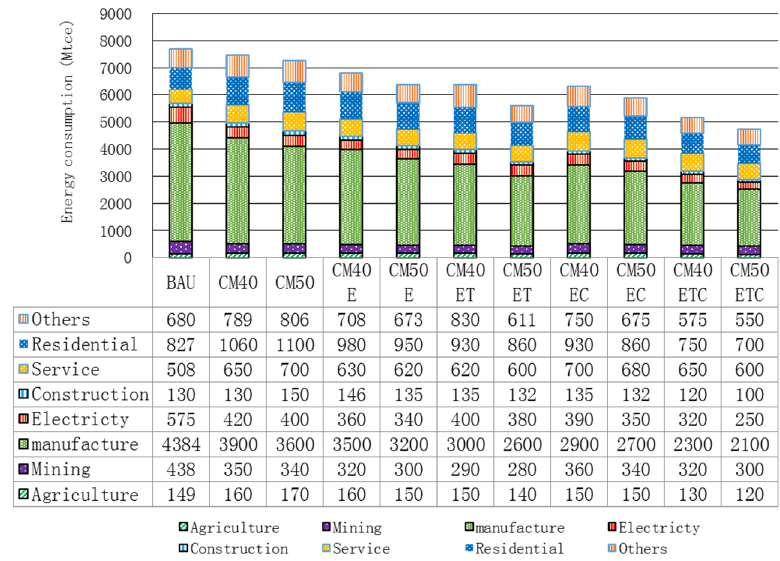
Figure 6. The total energy consumption by fuel types through 2050.